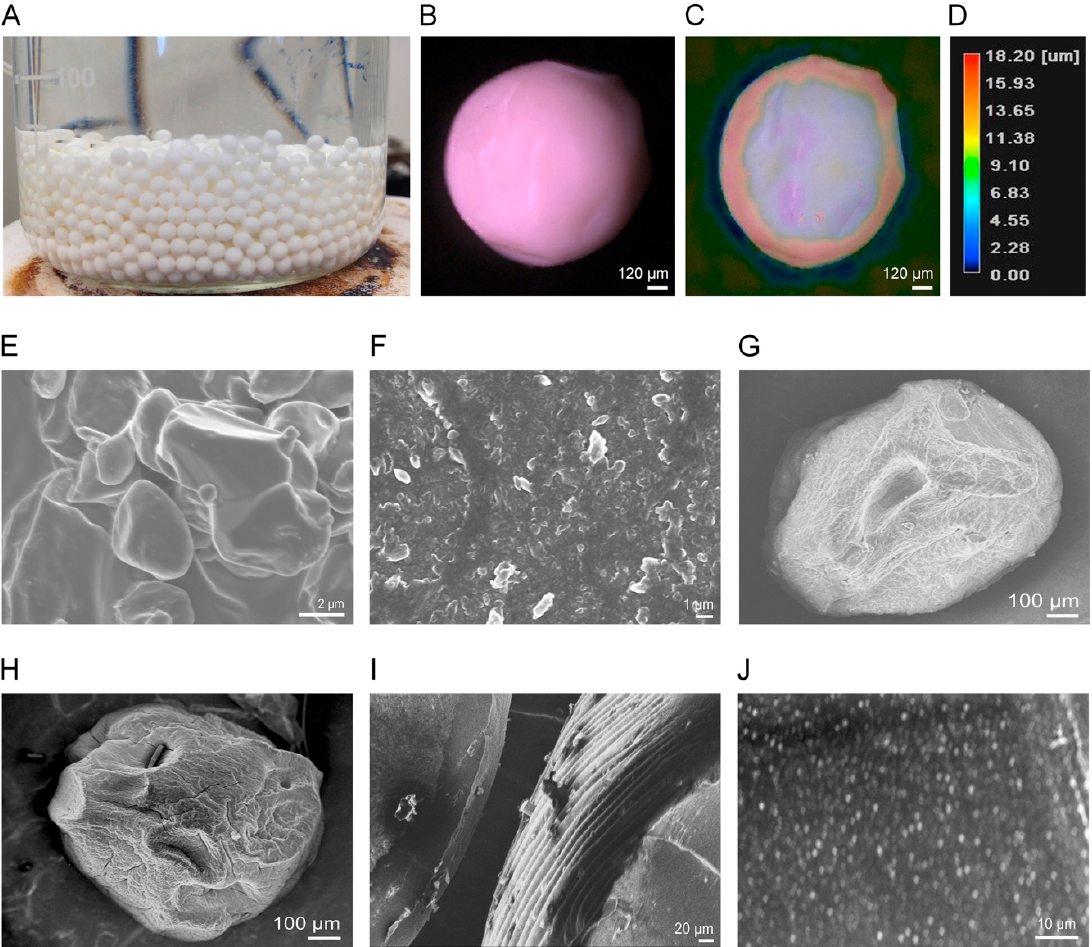
Figure 6. Production of NCSMs via a simple ionotropic crosslinking technique and characterization of the surface